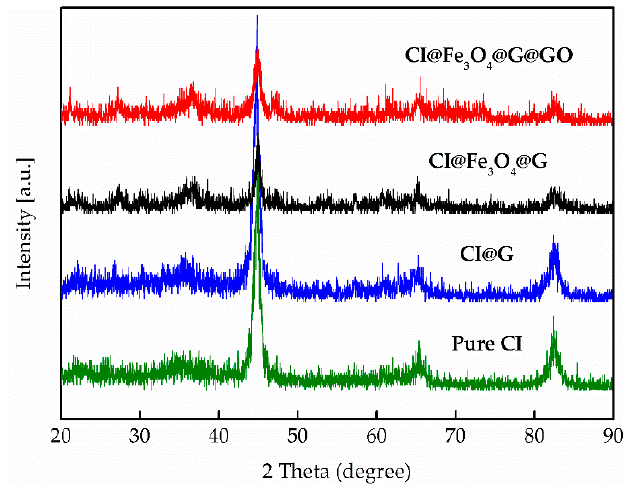
Figure 6. XRD spectra of pure CI, CI@G, CI@Fe 3 O 4 @G, and CI@Fe 3 O 4 @G@GO particles.